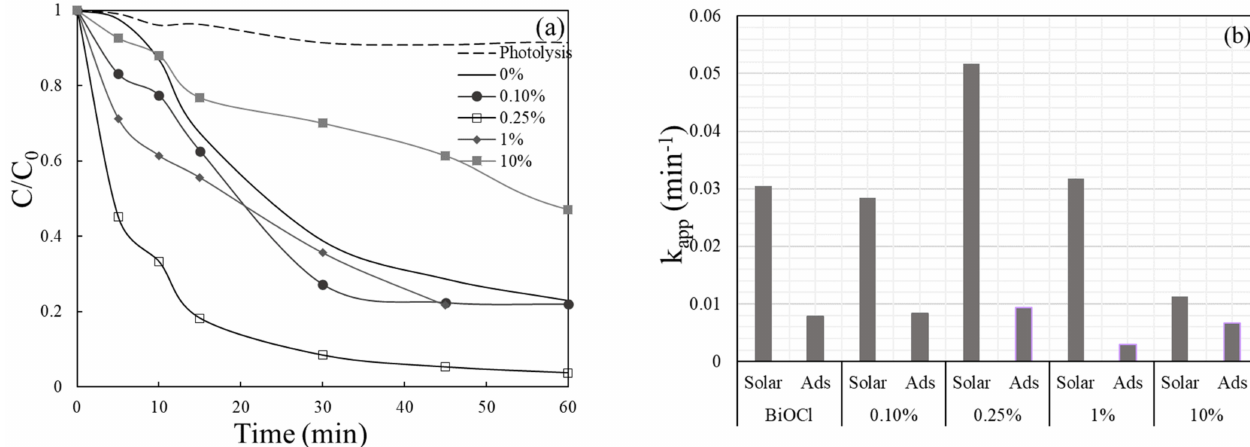
Figure 4. ( a ) Photocatalytic activity of 1000 mg/L BiOCl and MoS 2 /BiOCl composites for the degradation of 0.5 mg/L VLS in UPW. ( b ) Relationship between apparent rate constant and the different composites of the synthesized